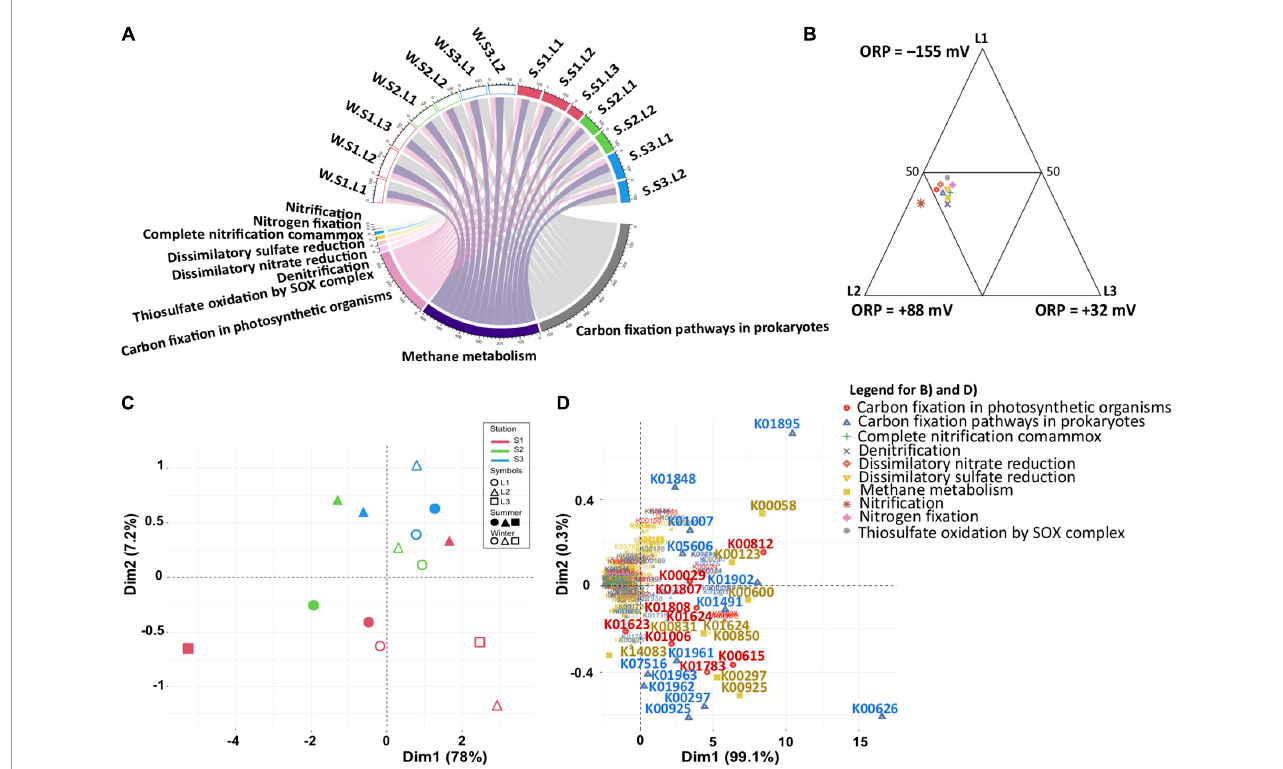
FIGURE5 Predicted functional analysis for sulfur, nitrogen, and carbon metabolism inferred from 16S rRNA gene data (PICRUSt2). (A) Chordogram showing the distribution of functions among samples. (B) Ternary plot showing the distribution of functions among layers. (C,D) Principal component analysis (PCA) showing the distribution of samples based on the PICRUSt2 predictive functions, and the functional genes, respectively. Winter, W (wet period); Summer, S (dry period); Stations: S1, S2, S3; Layers: L1, L2, L3.